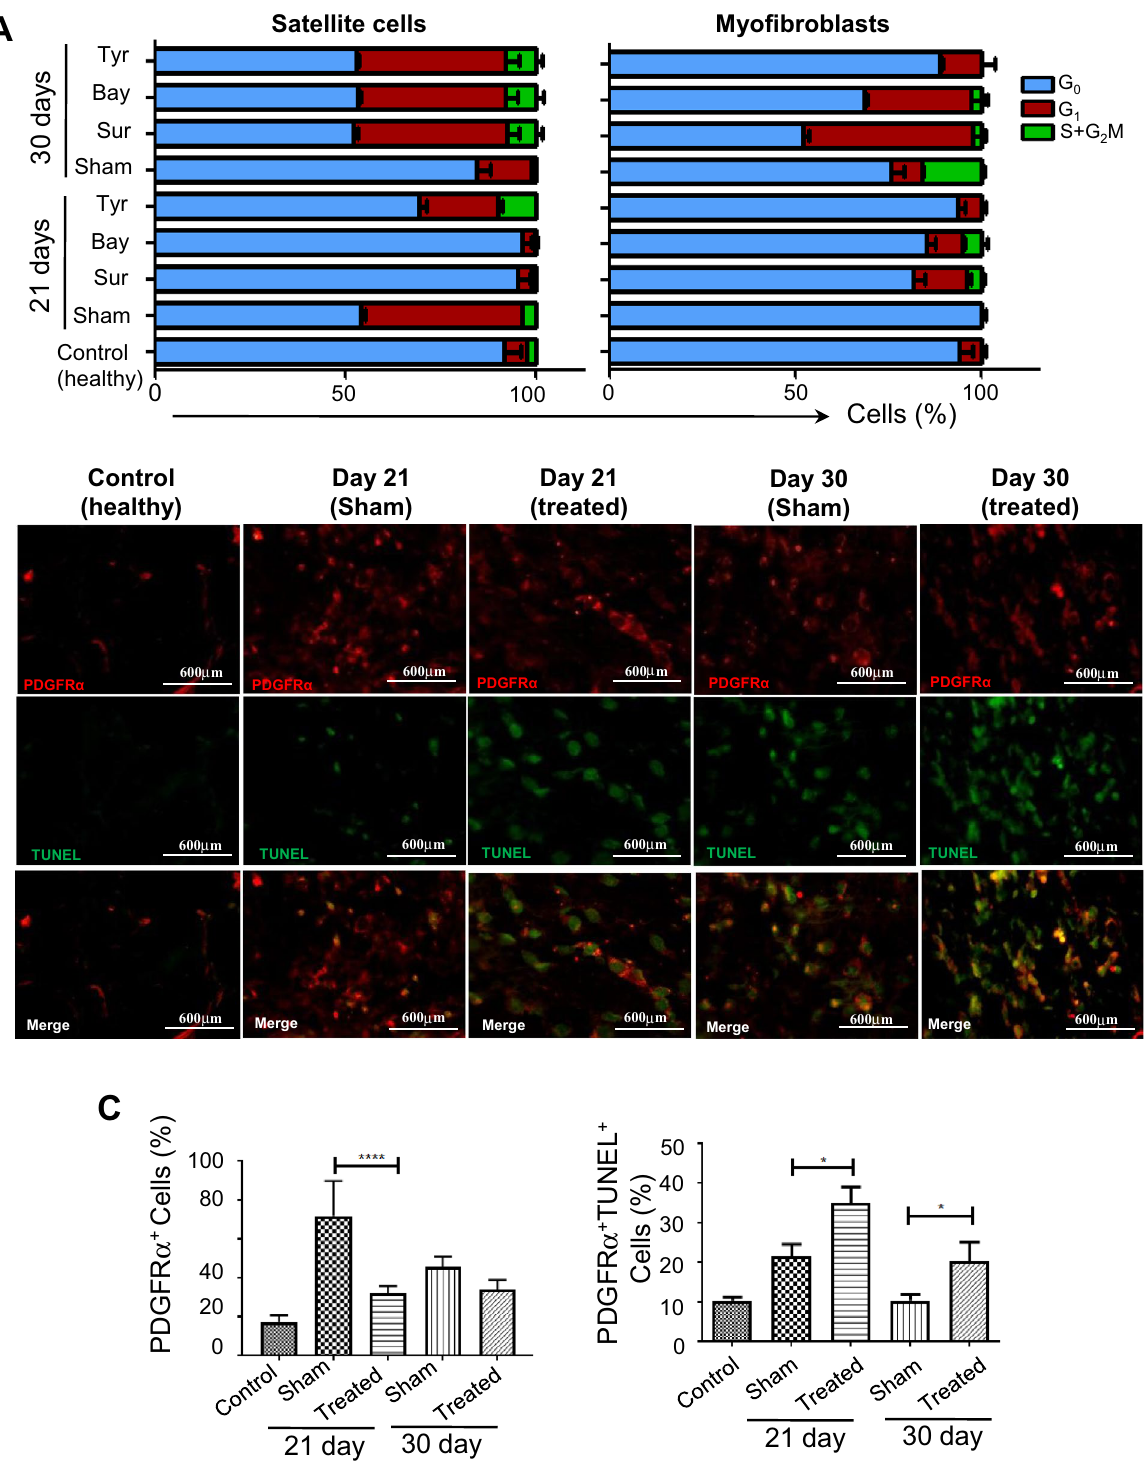
Figure 6. Growth inhibition and apoptosis of cells in the presence of inhibitors. ( A ) Cell cycle analysis. Experiments were conducted as above; both SCs and MFs fraction of muscle cells were analyzed for different phases of the cell cycle. Tissues were collected on days 21 and 30 post treatment with inhibitors (post days 7 and 16 of injection of drug) and without inhibitors (sham control). Separate cell cycle profiles of SCs and MFs are shown. ( B ) Apoptosis of MFs in the presence of Tyrphostin AG-370. Tissue samples (sham control and treated) were subjected to TUNEL assay post 21 and 30 days of injury (representative images—60× magnification). Bar diagrams represents the quantitative change of MFs and TUNEL-positive MFs, determined by morphometric analyses of 10 fields (20× magnification) using the ImageJ software. Data were presented as mean ± SEM. ***p < 0.001, **p < 0.01, *p <